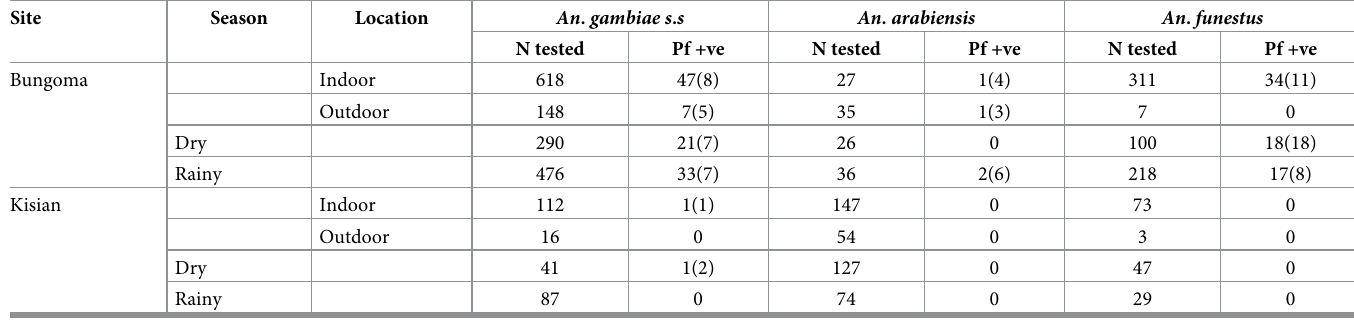
Table 3. Sporozoite rates of Anopheles mosquitoes from indoor and outdoor collections in Bungoma and Kisian, western Kenya.